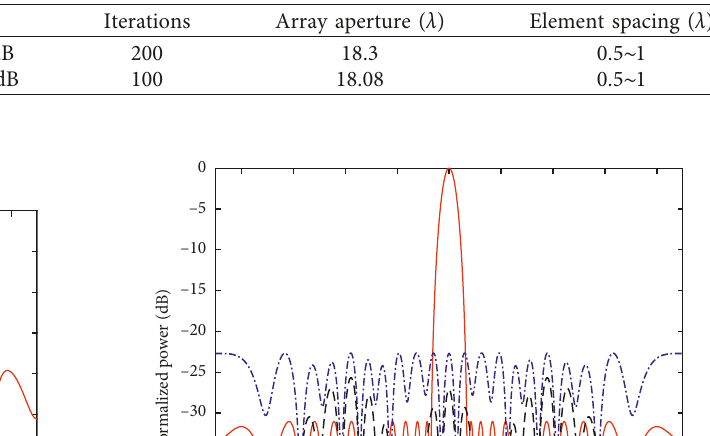
Table 3: Performance comparison of the TMSLA and SLA in [16].